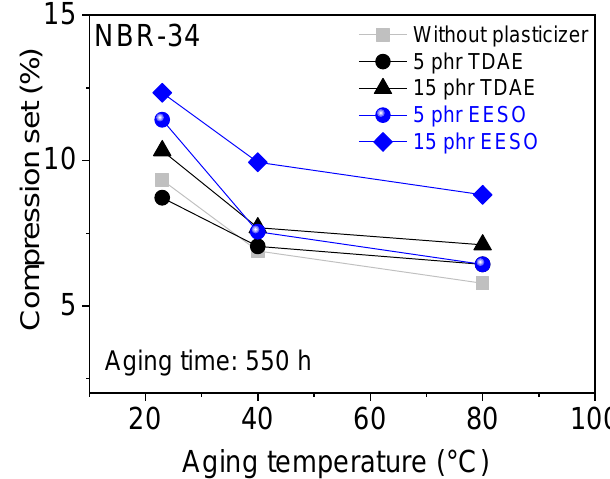
Figure 16. Compression set as a function of aging temperature for NBR-34 vulcanizates with various plasticizers.